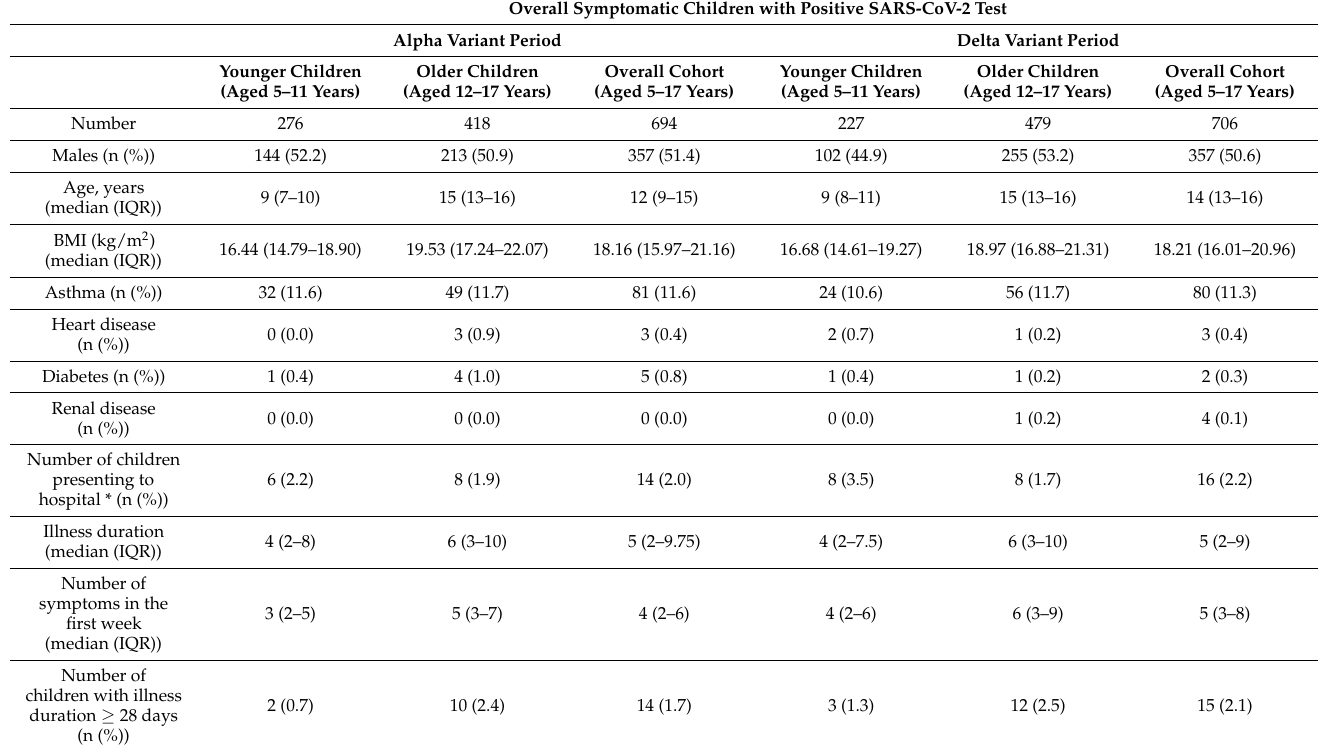
Table 1. Characteristics of UK school-aged children presenting with COVID-19 during periods of SARS-CoV-2 Alpha or Delta variant